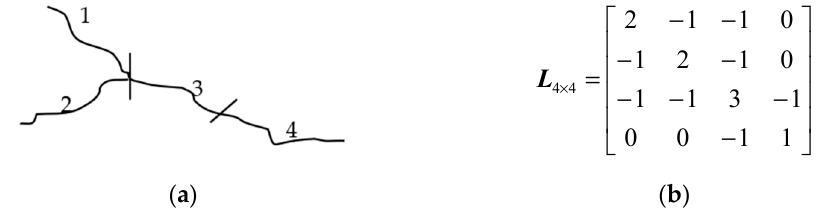
Figure 1. Example of ( b ) smoothing matrix for ( a ) a simulated river network.